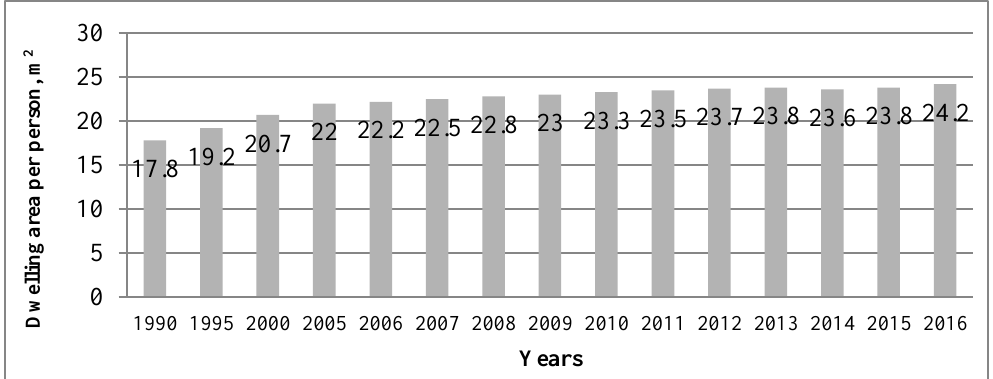
Fig. 1. Dwelling area per person in Ukraine between 1990–2016, m 2 . Source: State Statistics Service of